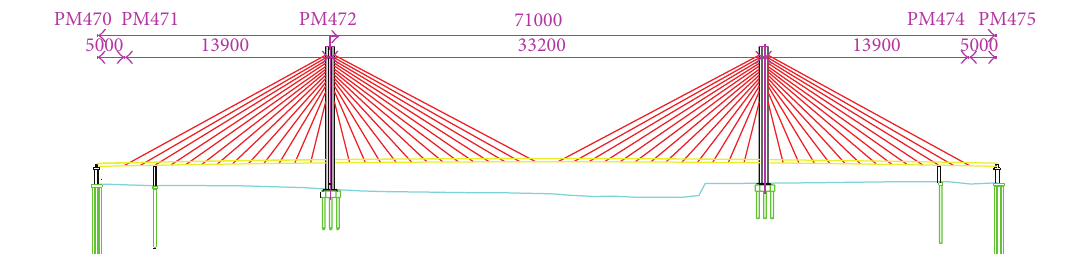
Figure 3: Elevational view of the Kezhushan bridge.